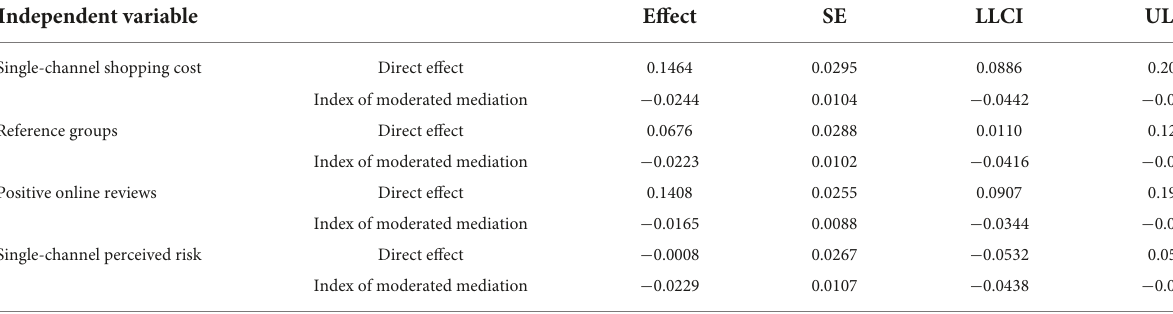
TABLE 6 Summary of moderated mediation